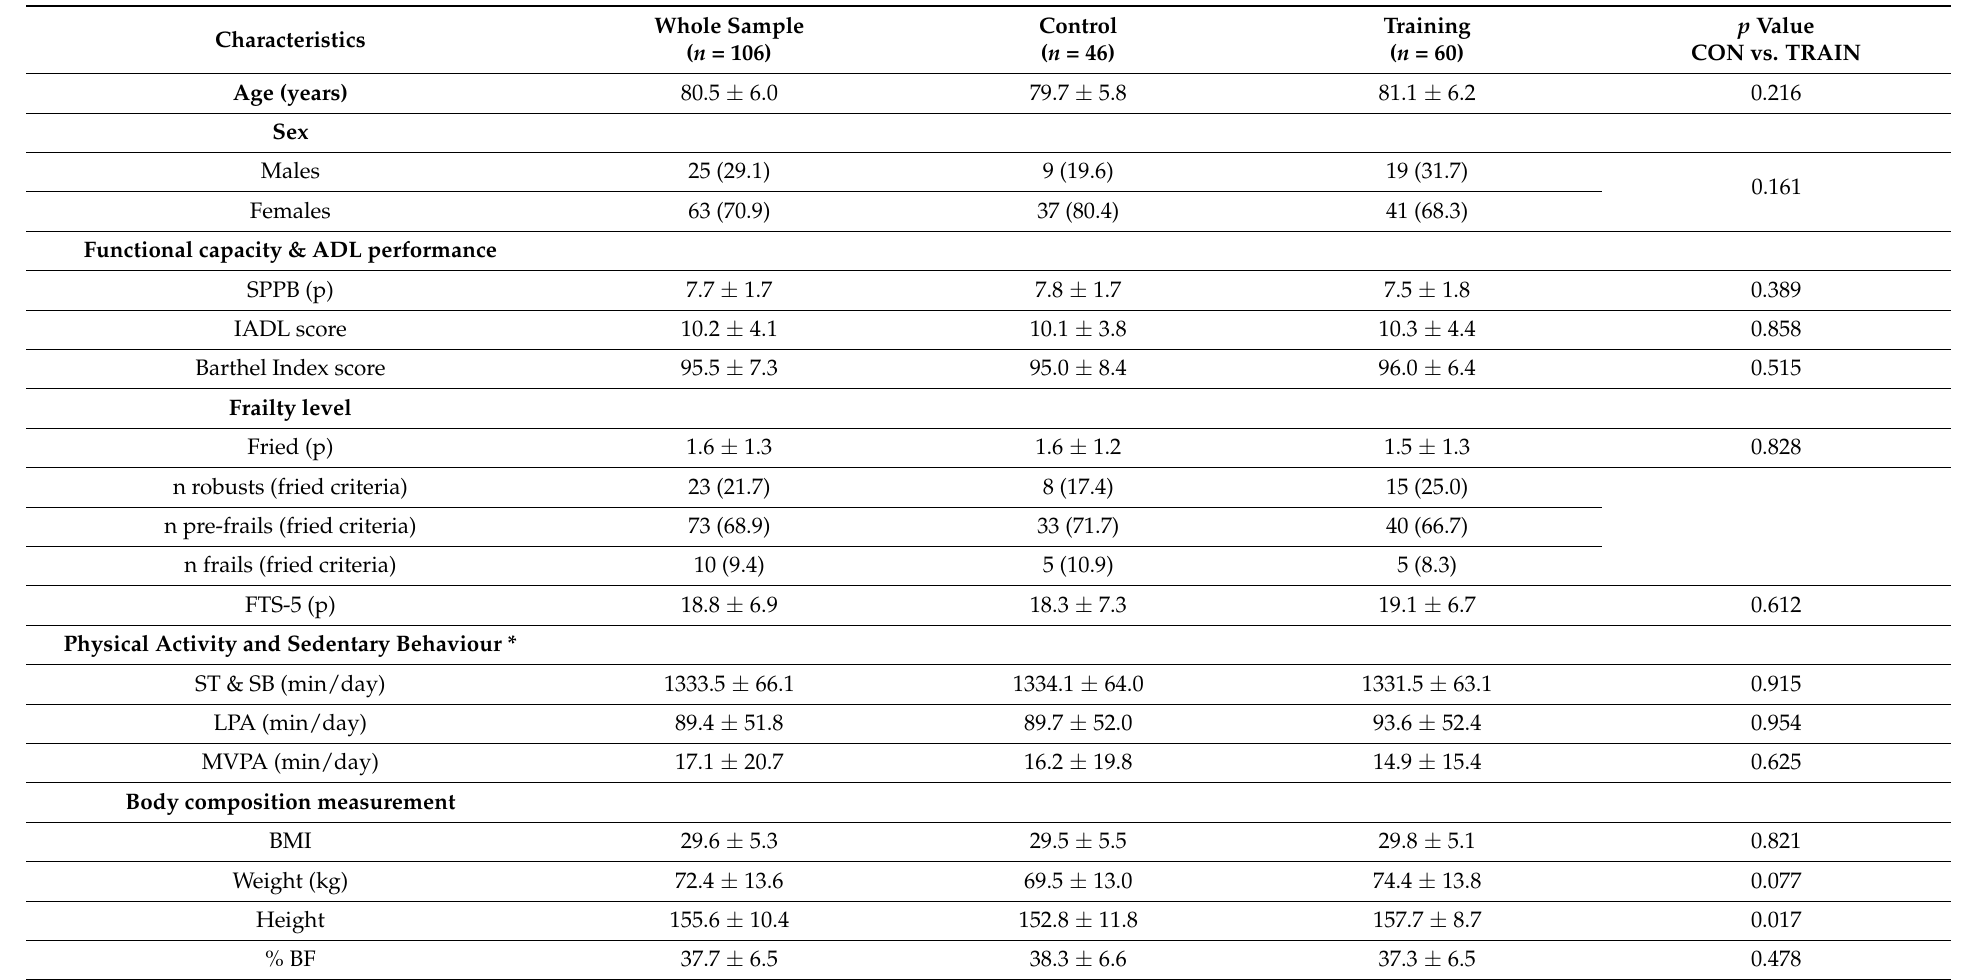
Table 3. Characteristics of CON and TRAIN at